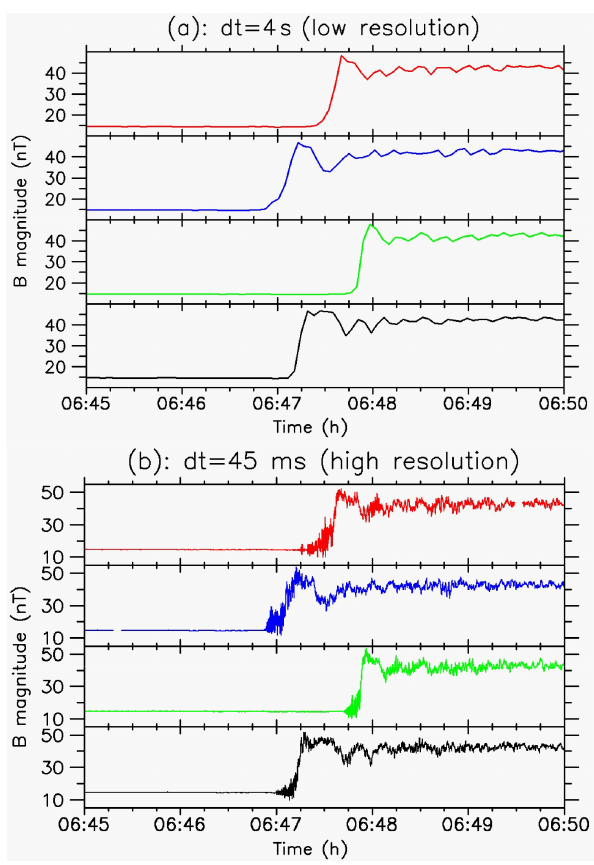
Figure 1. Total magnetic field amplitude measured versus time dur- ing the same shock crossing by each of the four Cluster satellites on 22 April 2001 around 06:47UT ( M A = 3 . 8; β i = 0 . 04 so that = 89 ◦ ). The same measurement is performed at v sh /v thi (cid:29) 1, θ B n low time resolution (d t = 4s in panel a ) and high time resolution (d t = 45ms in panel b